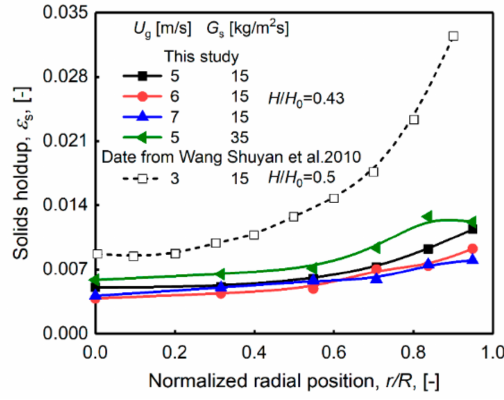
Figure 4. Radial distribution of the solids holdup under different operating